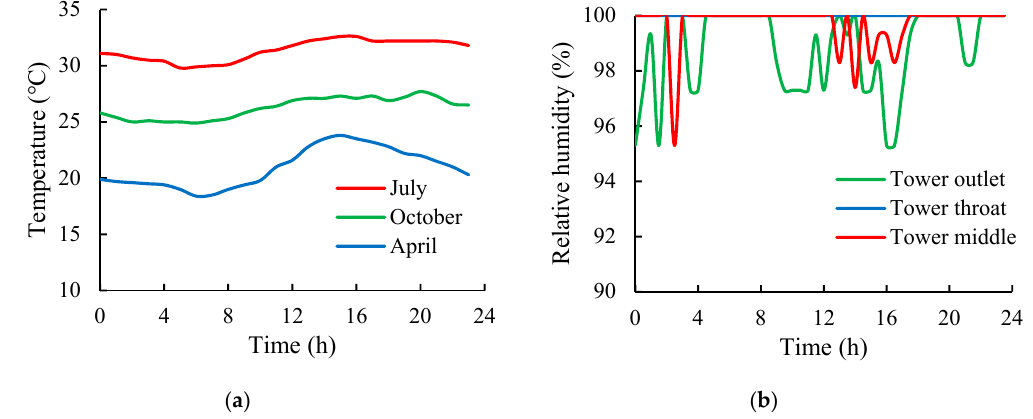
Figure 3. Typical temperature and relative humidity over 24 h in the cooling tower. ( a ) Temperature; ( b ) relative humidity.